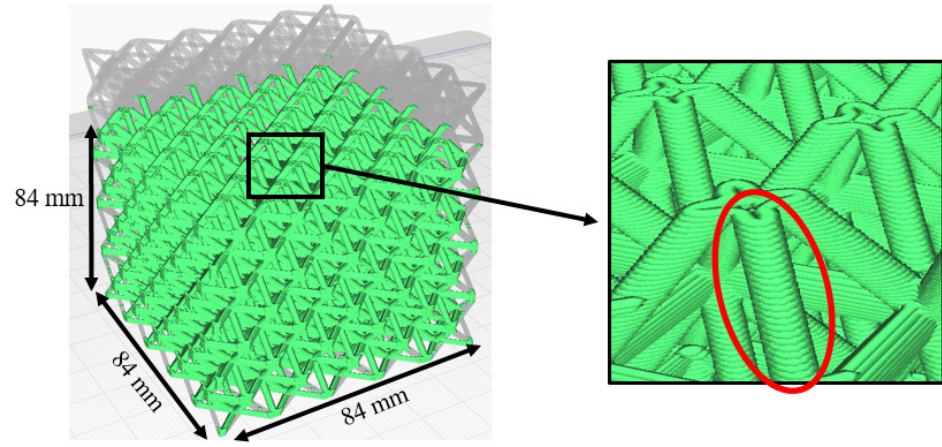
Figure 3. 3D lattice structure (left), and close-up view showing how individual cylindrical beams are produced as the result of a lamination of dozens of layers with small cross-sectional areas.